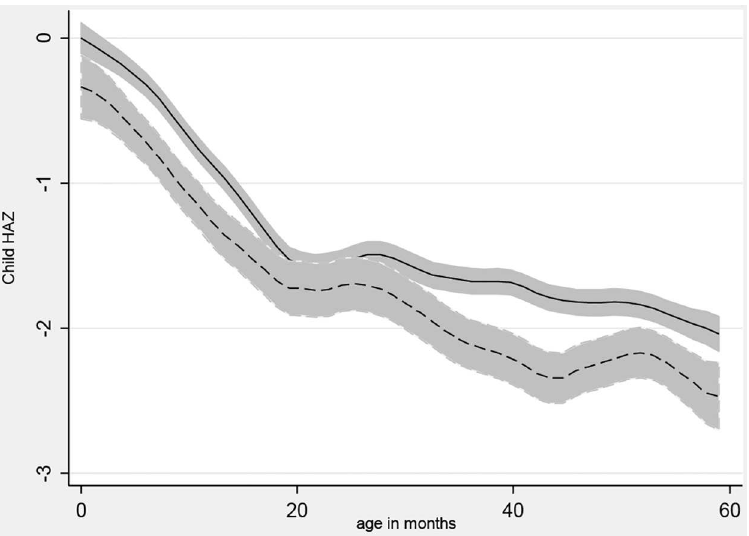
Fig 1. HAZ by child age and household remoteness. Notes: A local polynomial smoothingregressionof child heights at each month of age, stratified by place of residence and the presenceof seasons.Remote with seasons is dashed line. 95% ConfidenceIntervals